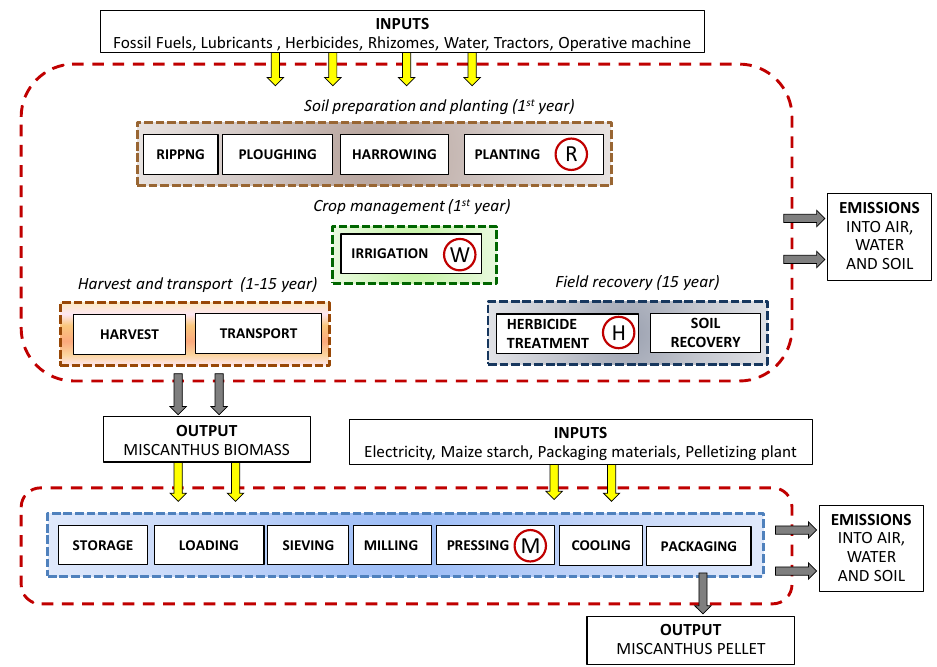
Figure 1. System boundary for the cradle to gate life cycle assessment of miscanthus pellet production (R = rhizomes, W = water, H = herbicide, M = maize starch).